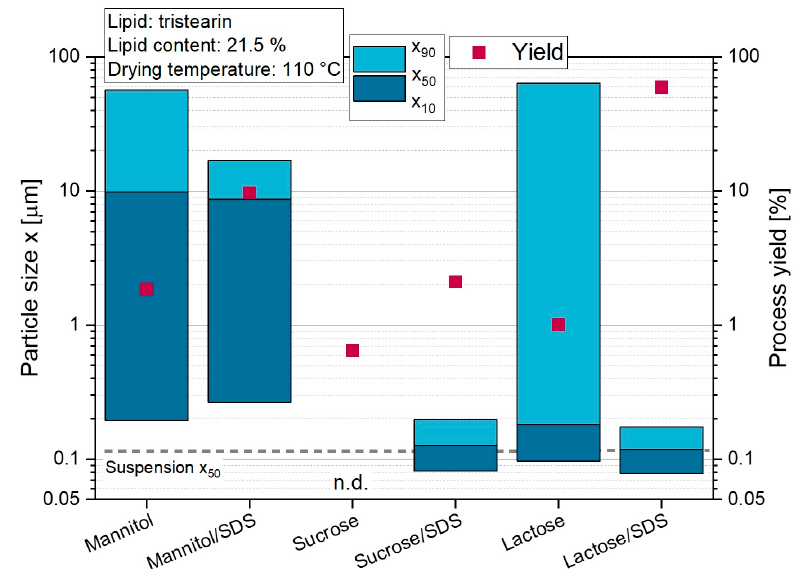
Figure 1. Effect of the matrix material on the size of tristearin nanoparticles after redispersion of lipid-containing powders in water and on the yield of the spray-drying process (n.d. = not